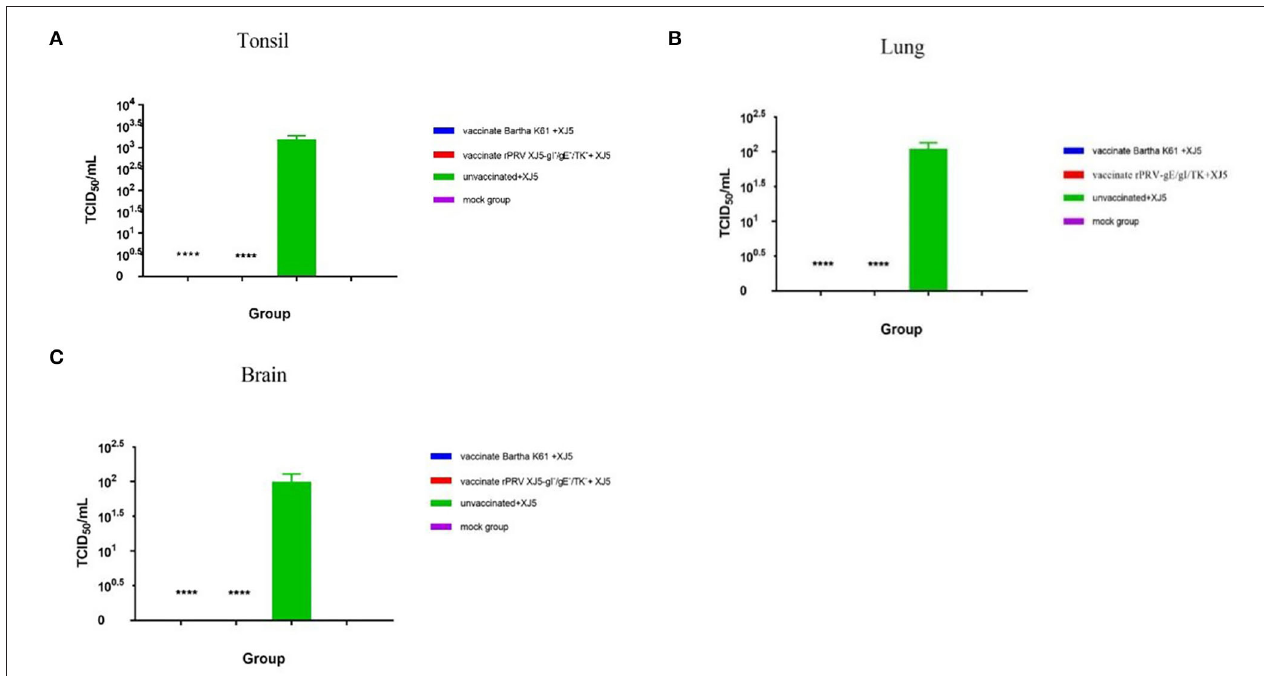
FIGURE 6 | PRV viral loads in tonsil (A) , lung (B) , and brain (C) tissues of pigs upon necropsy at 14 d.p.c. (error bars represent standard errors of the mean of each group all replicates); **** p < 0.0001 compared with challenge-only pigs.